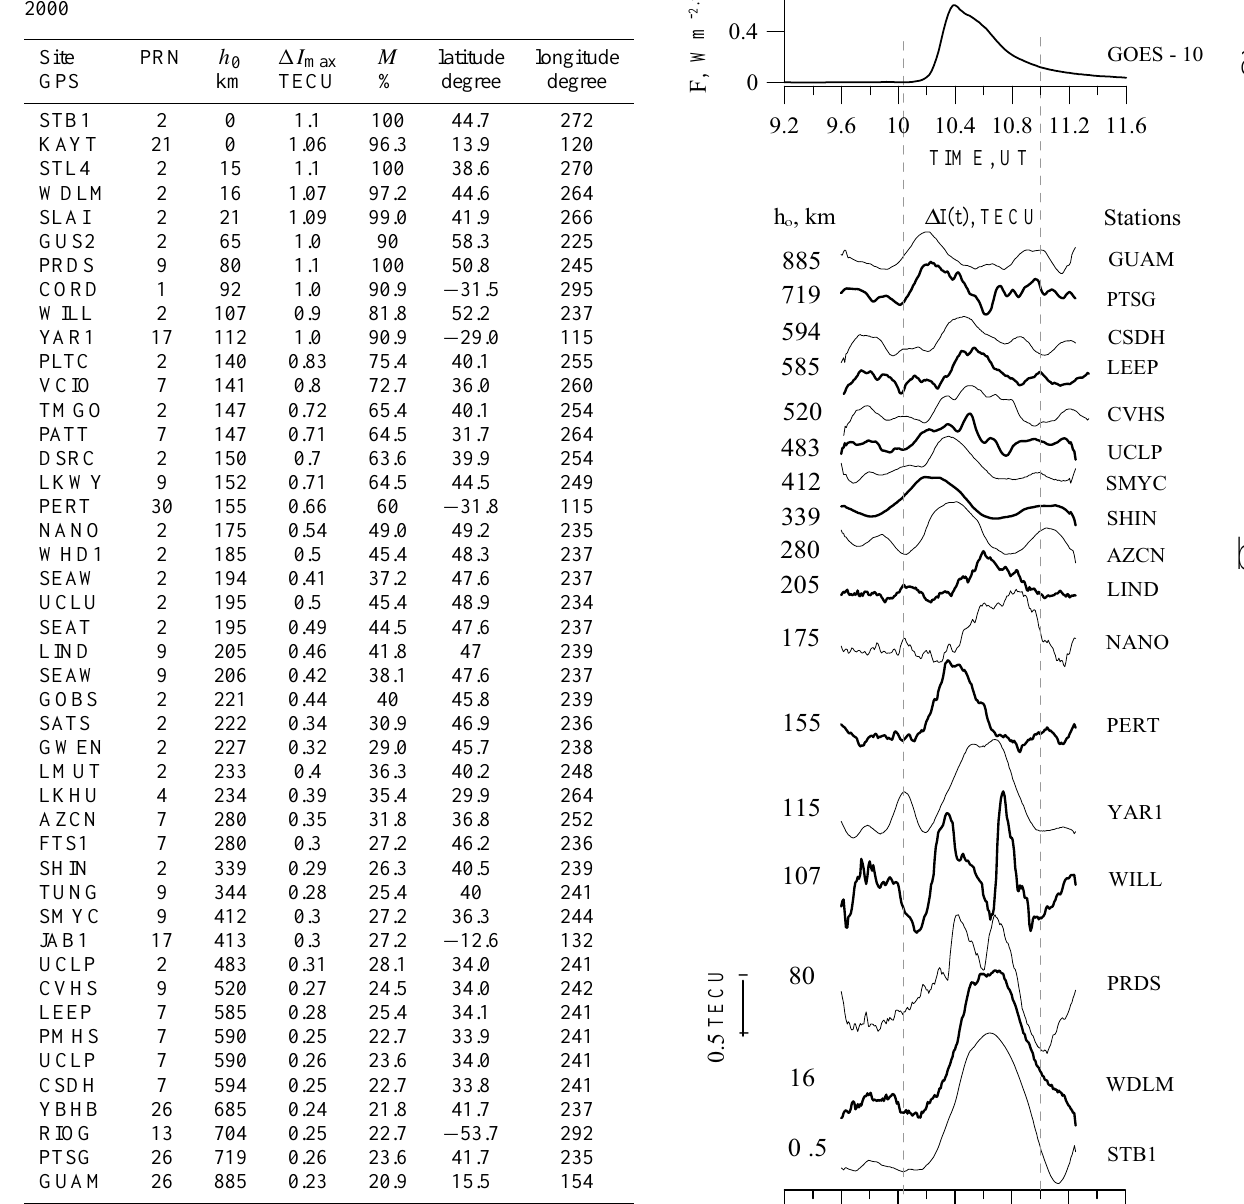
Table 1. Parameters of response TEC during solar flare of 14 July